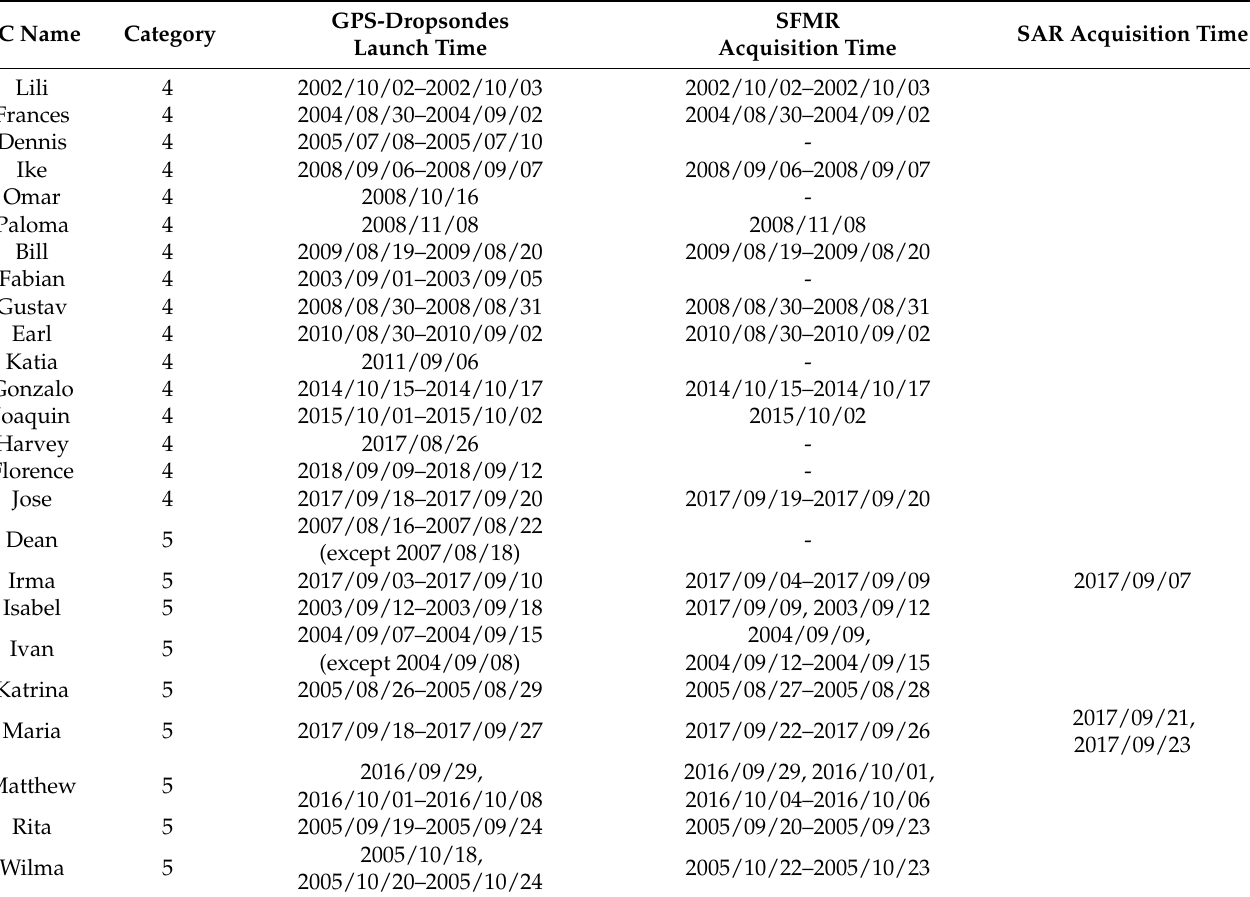
Table 1. Tropical cyclones selected for the analysis and the acquisition time for different